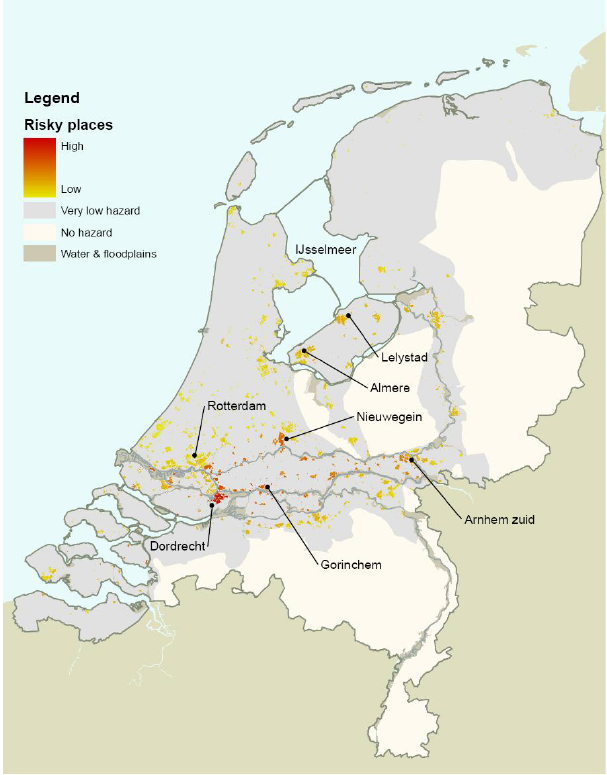
Fig. 3. At “risky places” unbreachable embankments may be very effective in reducing the risk of loss of life (De Bruijn and Klijn, Figure 3. At ‘risky places’ unbreachable embankments may be very effective in reducing the 3 2009). risk of loss-of-life (De Bruijn and Klijn, 2009). 4